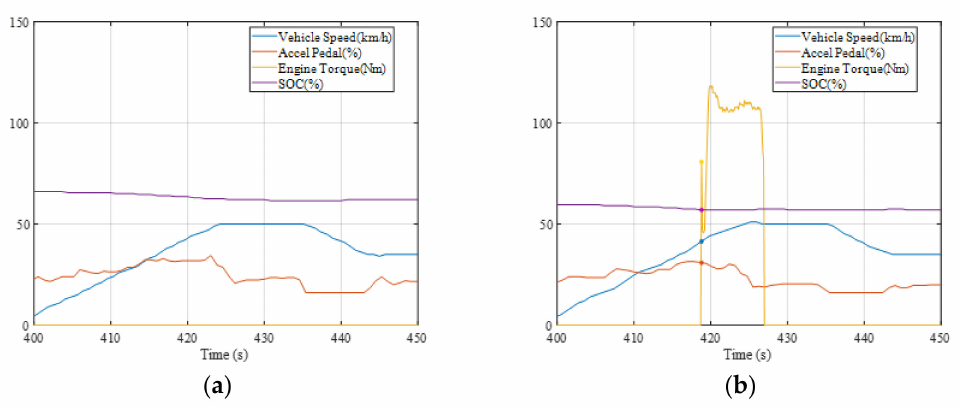
Figure 10. Dynamometer Test Results with NEDC Cycle: ( a ) NEDC Cycle Test Results with High SOC ,